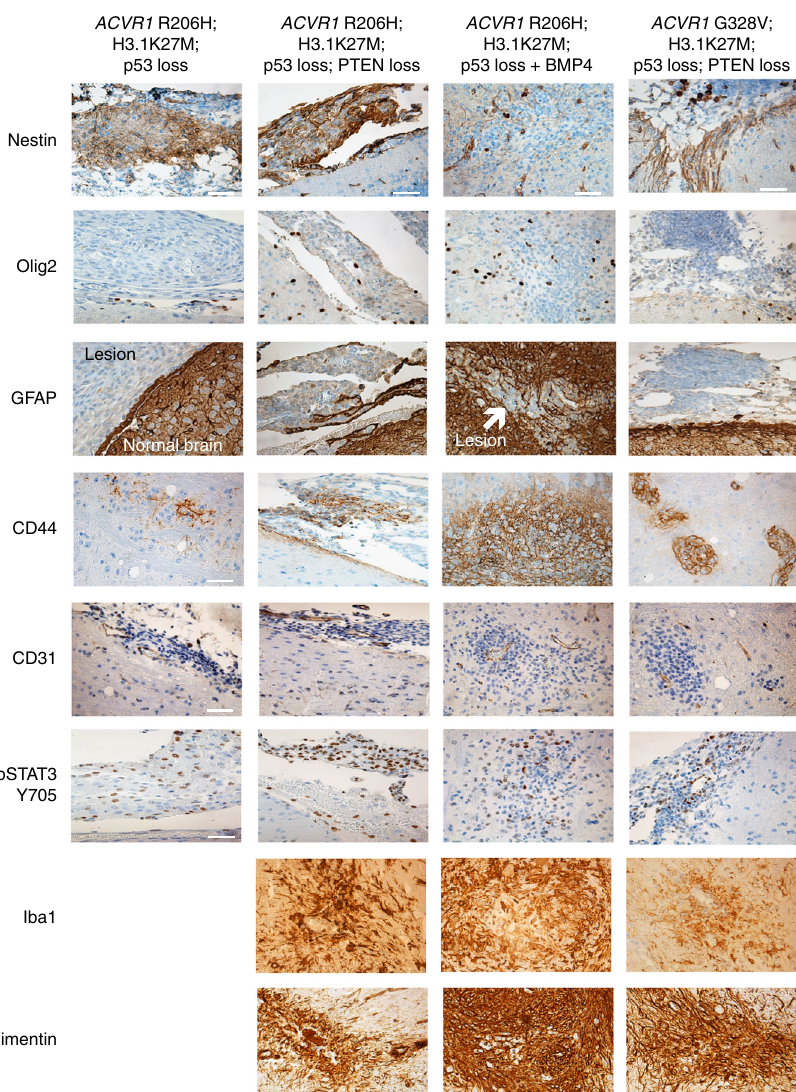
Fig. 3 Glioma-like lesions express a mesenchymal-like phenotype. Representative IHC images of Nestin, Olig2, GFAP, CD44, CD31, pSTAT3 Y705, Iba1, and Vimentin of glioma-like lesions (×40 magni fi cation, scale bar = 50 μ